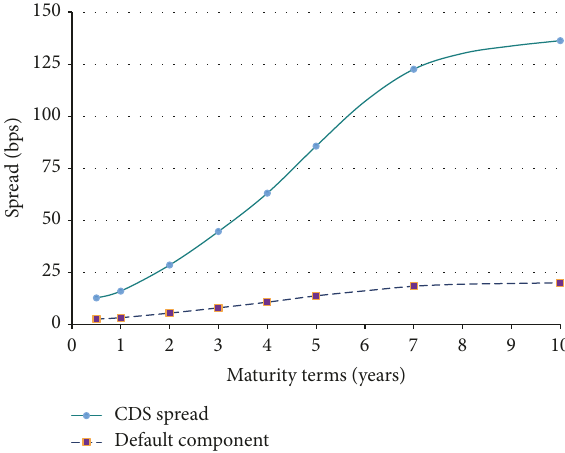
Figure 4: CBS Corp term structures: CDS spread and default com-